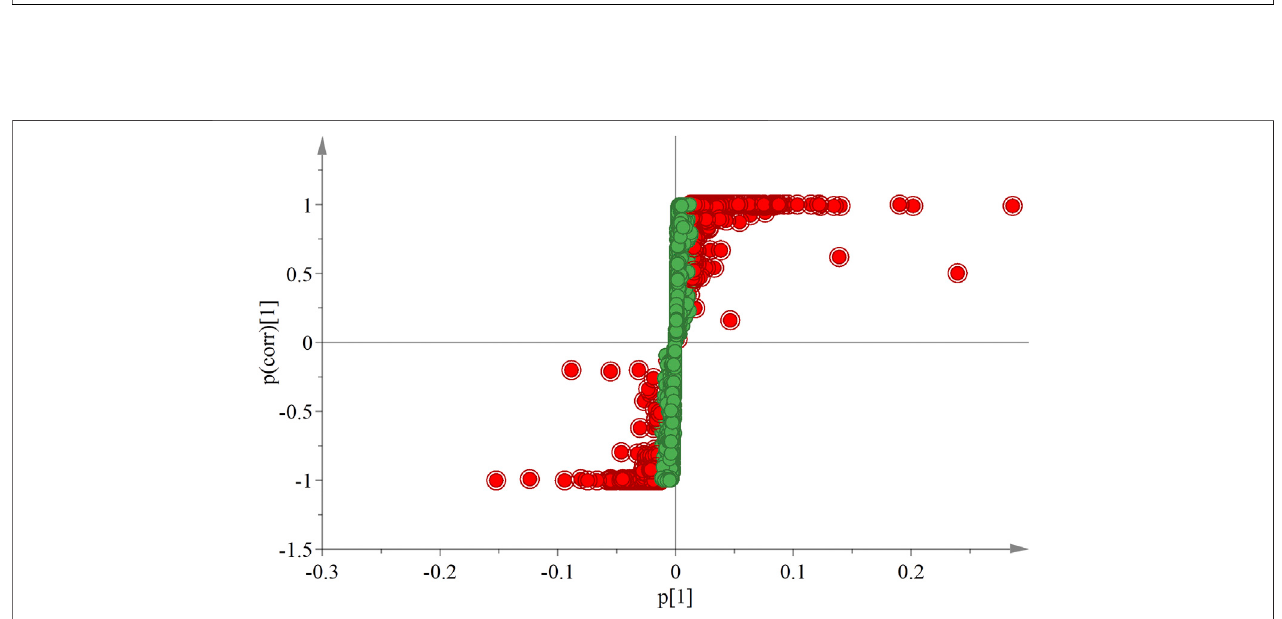
Frontiers in Pharmacology |